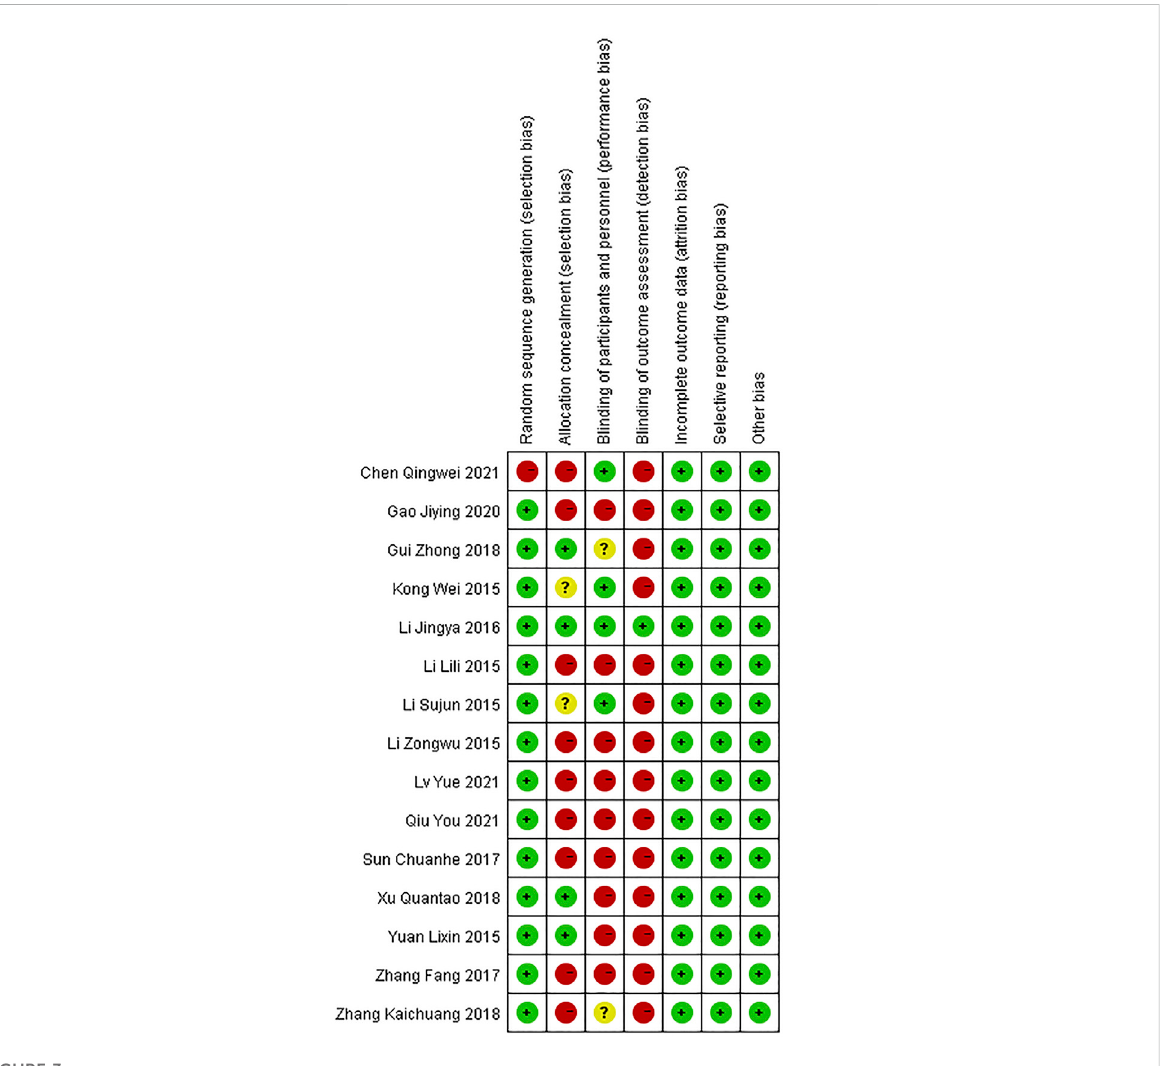
FIGURE 3 Risk of bias summary for included